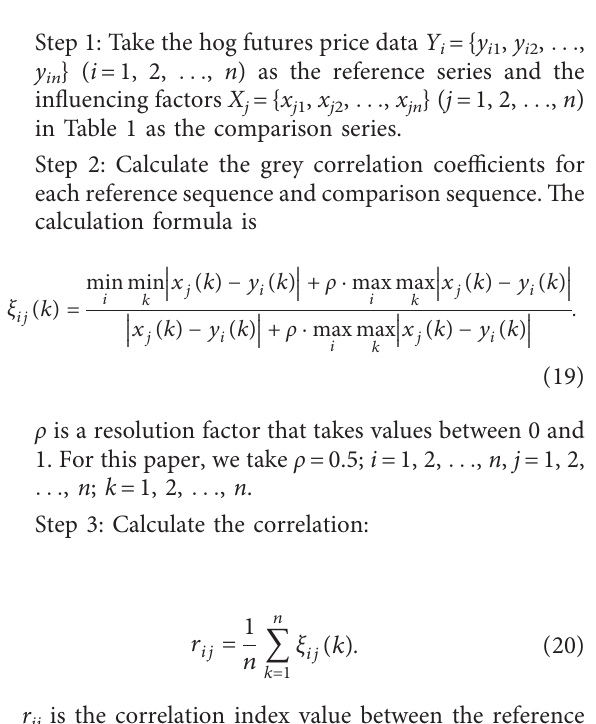
Figure 2: Structure flow chart of